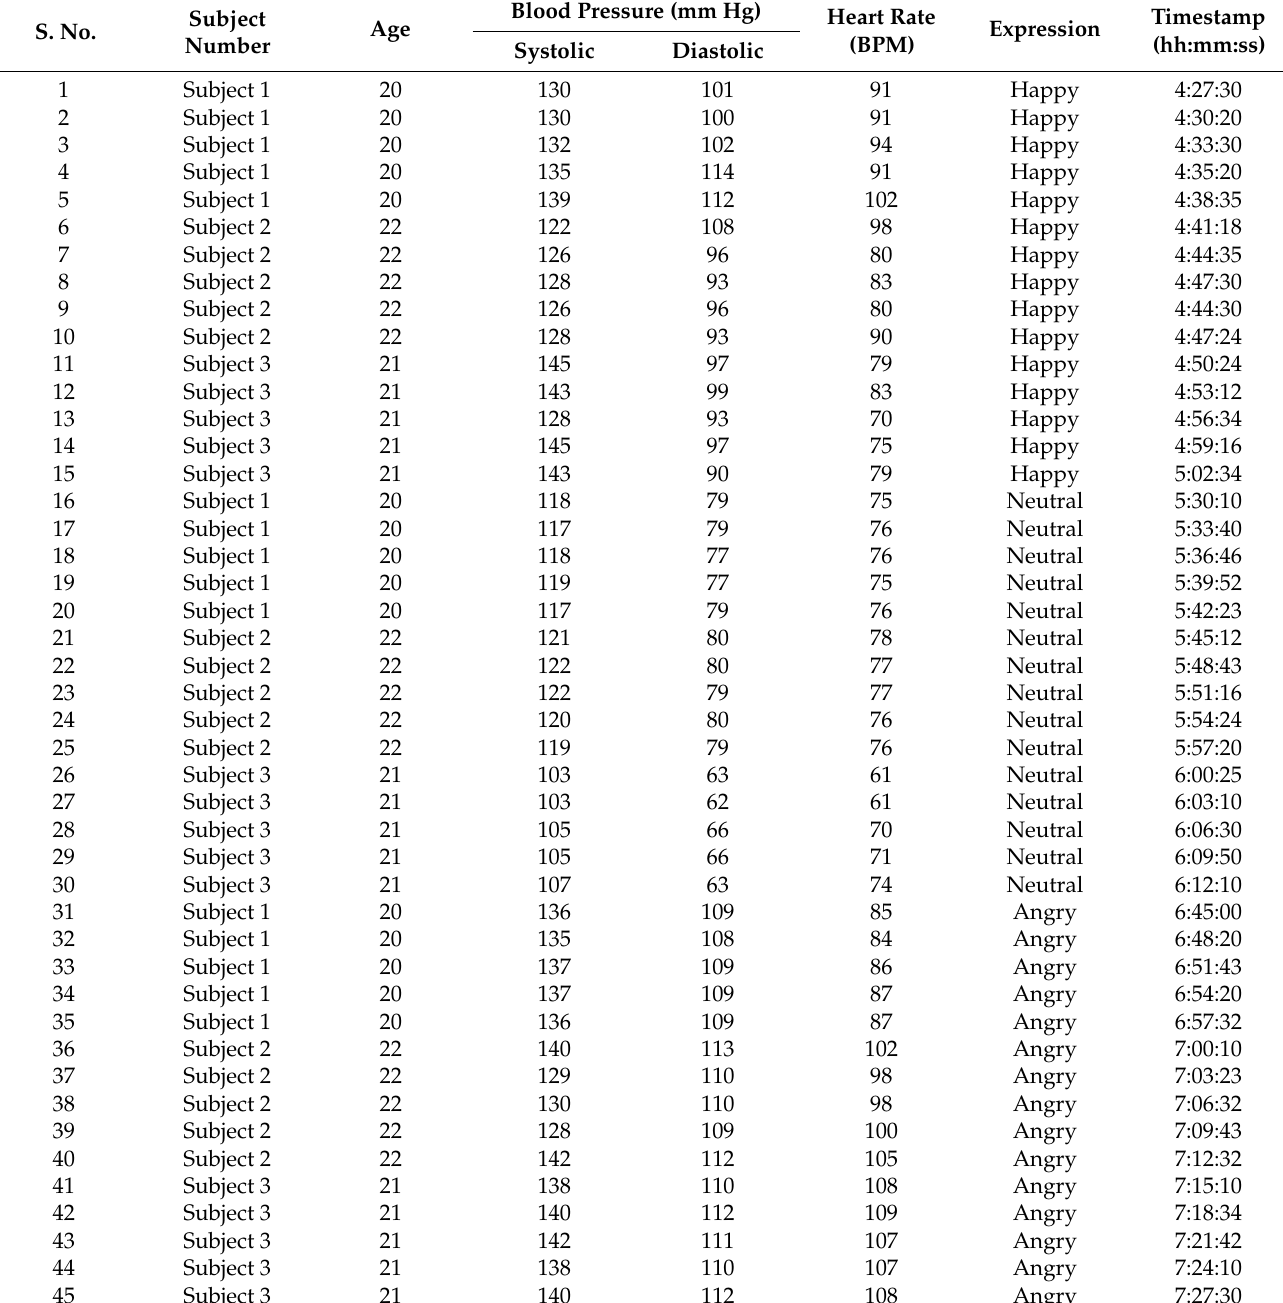
Table 4. Experimental results of the three subjects under happy, neutral, and angry conditions. S. No.